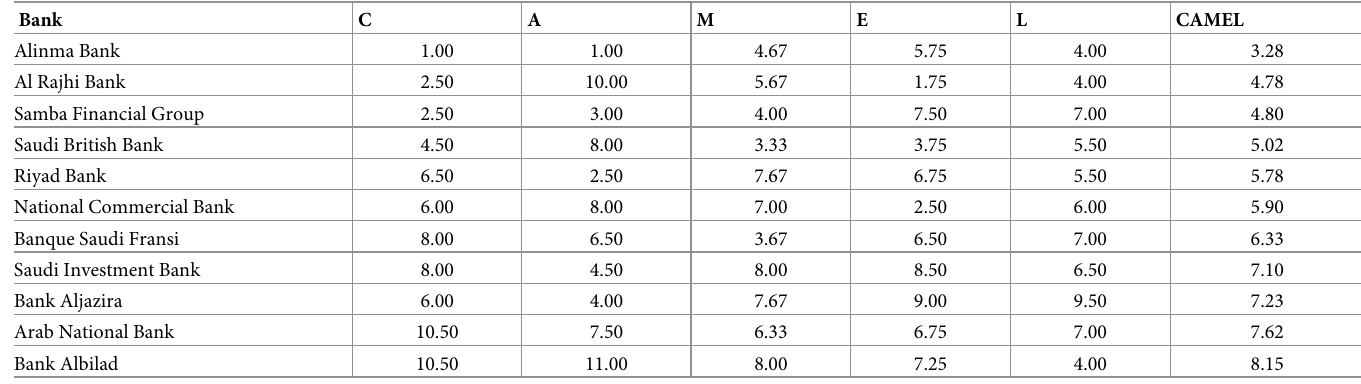
Table 3. Overall ranking of Saudi banks using CAMEL. Bank